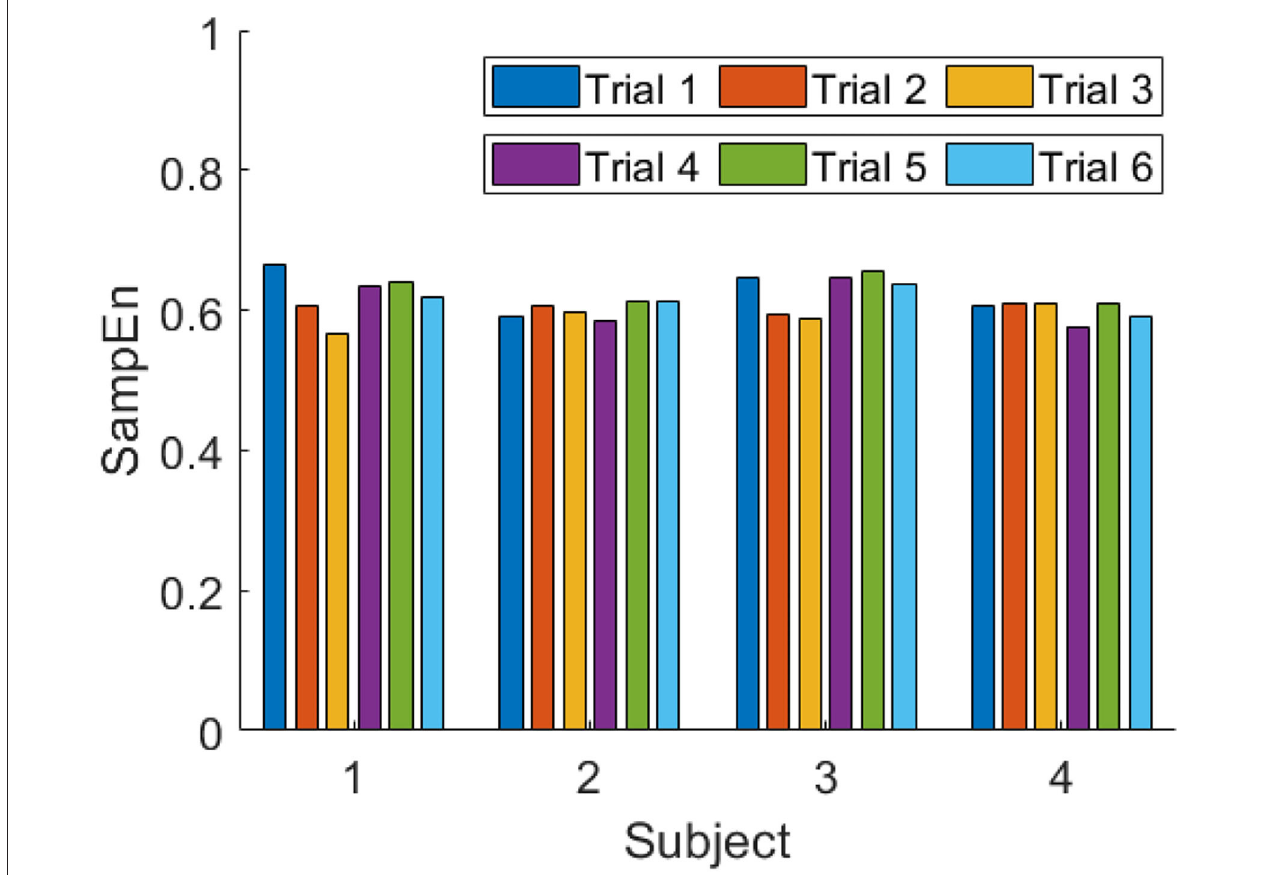
FIGURE 6 | SampEn of all trials for each